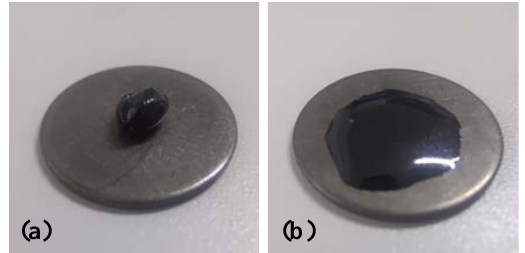
Figure 1. Samples ( a ) before and ( b ) after heating.